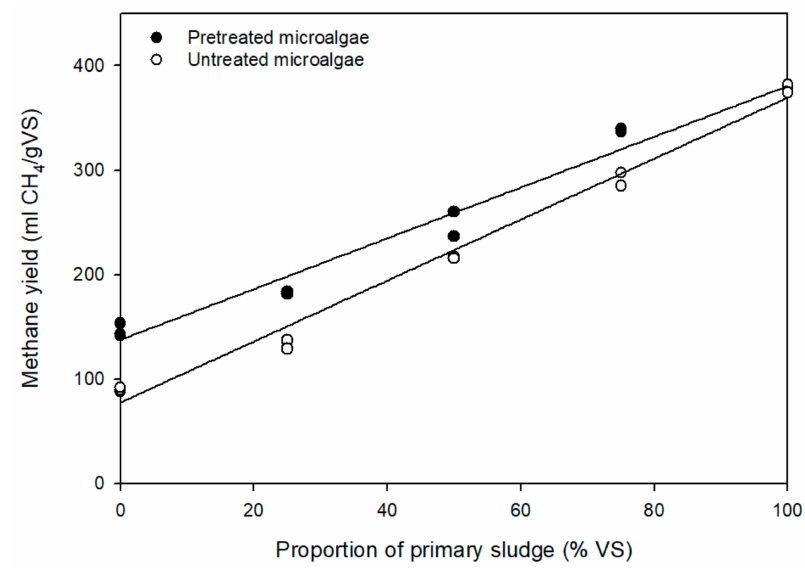
Figure 1. Correlation between the methane yield and the primary sludge proportion added to untreated and pretreated microalgae.